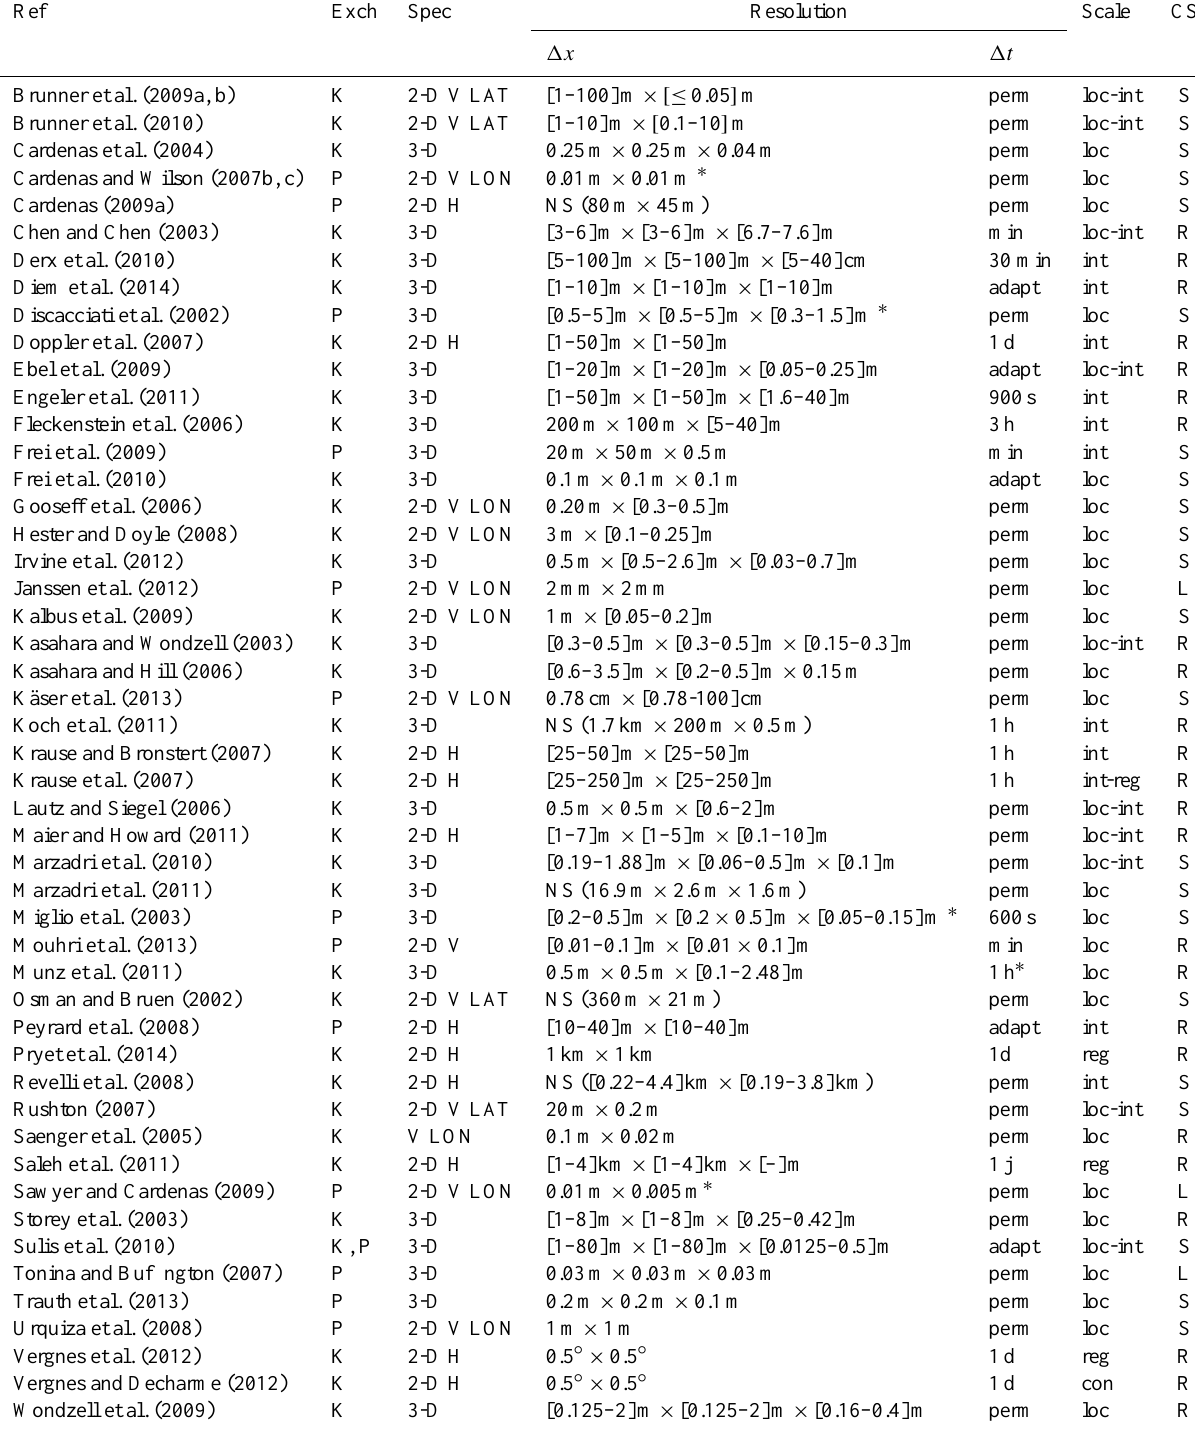
Table 1. Physically based modelling of stream–aquifer